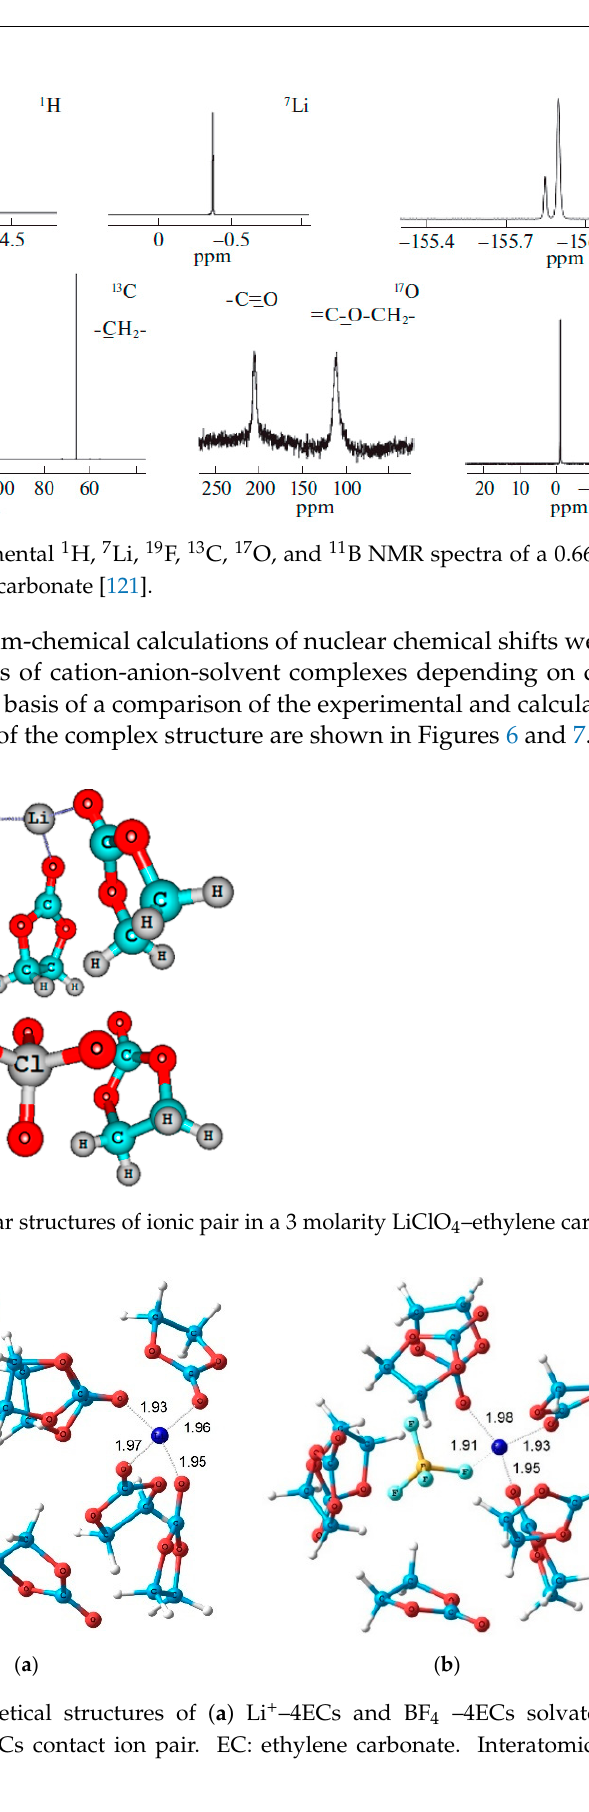
Figure 4. 1 H, 7 Li, 35 Cl, 13 C, and 17 O NMR spectra of LiClO 4 –ethylene carbonate solutions [120].